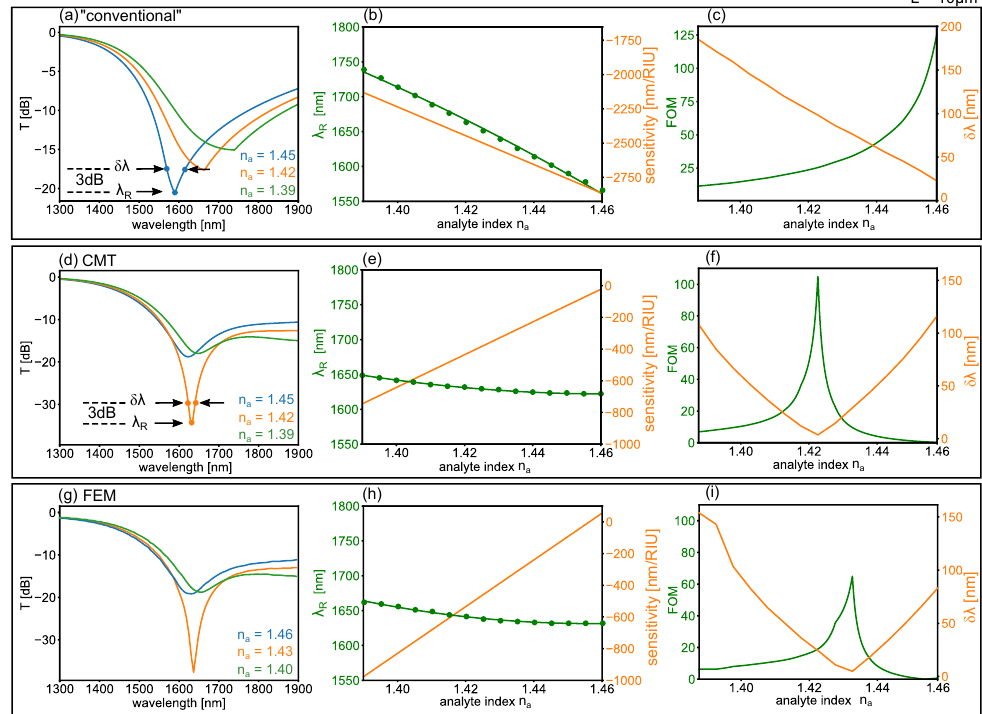
Figure 8. ( a ) Transmission spectrum using the “conventional” approach of Equation (14), as a function of wavelength, for the three analyte indices as labelled, using L = 10 µ m. Also shown are the resonant wavelength λ R , corresponding to the spectral minimum and the δλ , corresponding to the FWHM. ( b ) Associated λ R vs. n a (green circles, left axis), second order polynomial fit (green line), and resulting sensitivity S (orange line, right axis.) Also shown in ( c ) are the δλ vs. n a (orange curve, left axis) and the total FOM = S / δλ . ( d – f ): same as ( a – c ), obtained from the CMT approach, using a subset of the data shown in Figure 5a as labelled. ( g – i ): same as ( d – f ), obtained from FEM calculations, using a subset of the data shown in Figure 5b as